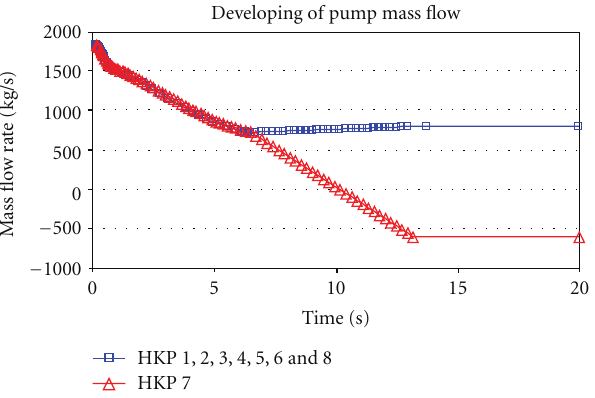
Figure 13: MRP mass flow rate during the transient.